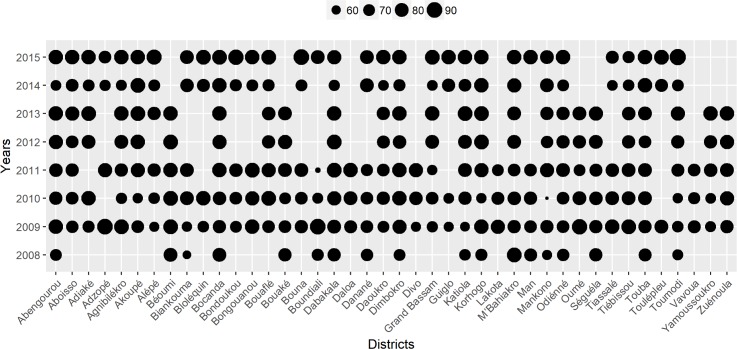
Proportion (%) of eligible people treated against onchocerciasis (therapeutic coverage) in endemic districts from 2008 to 2015.